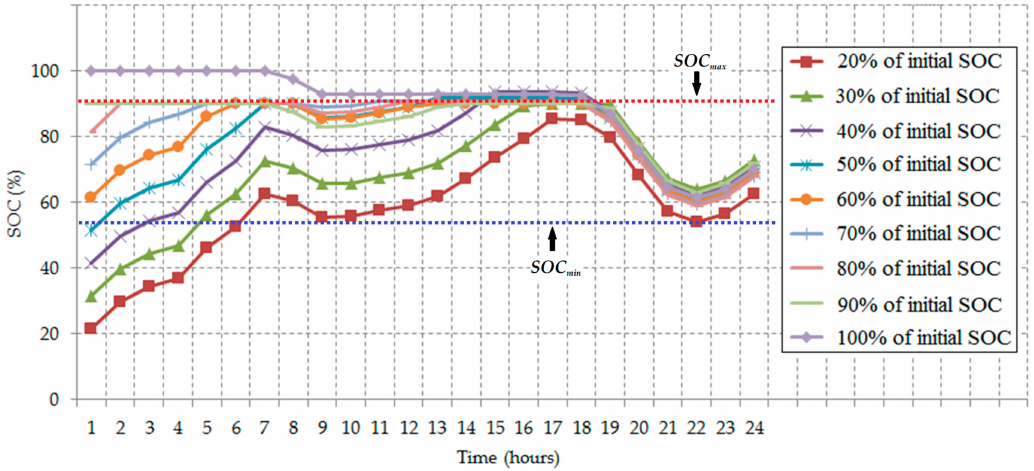
Figure 12. The SOC status of random selected EVs under the best optimized